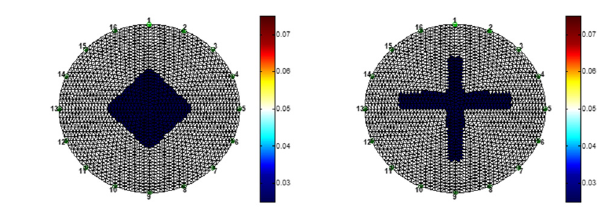
Fig.3: Conductivity distributions simulated to verify use of